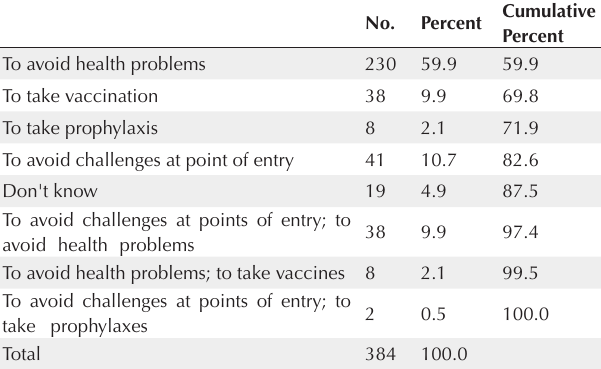
Table 5. Awareness of Existing Travel Recommendations on Yellow Fever